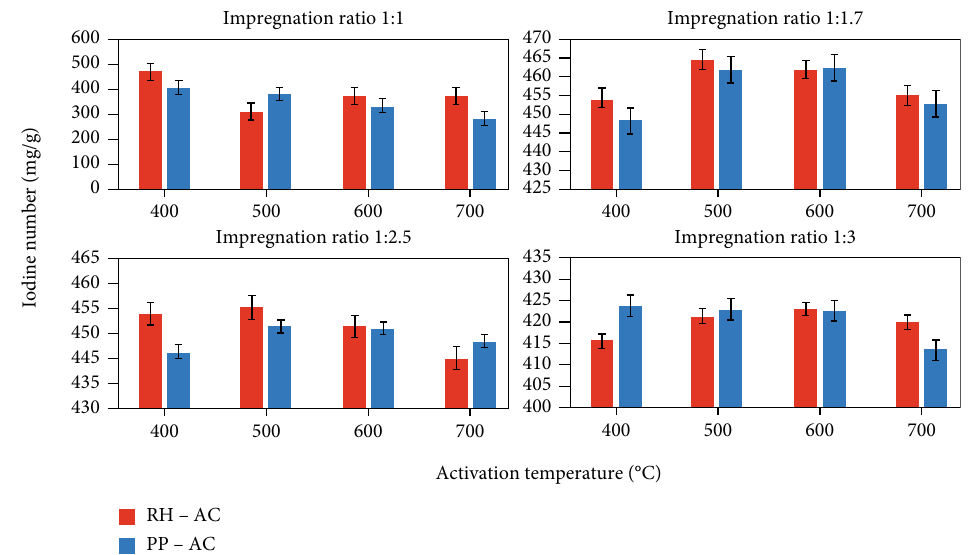
Figure 3: The iodine number of the prepared activated carbon